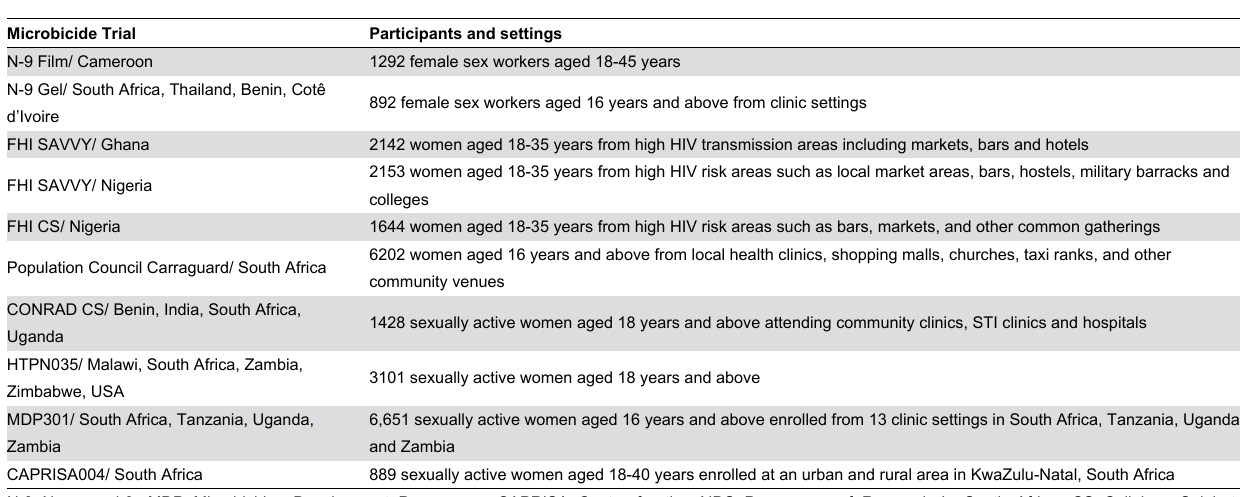
Table 2. A summary of characteristics of included